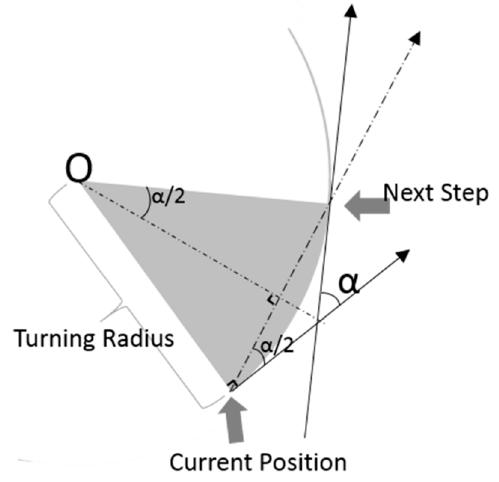
Figure 4. Generating the arc path.